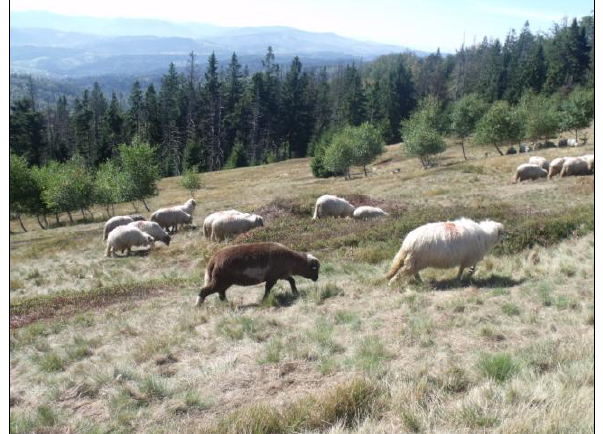
Fig. 4. Wasteland in Rycerka Dolna (the Raczańskie mountain range) 2014